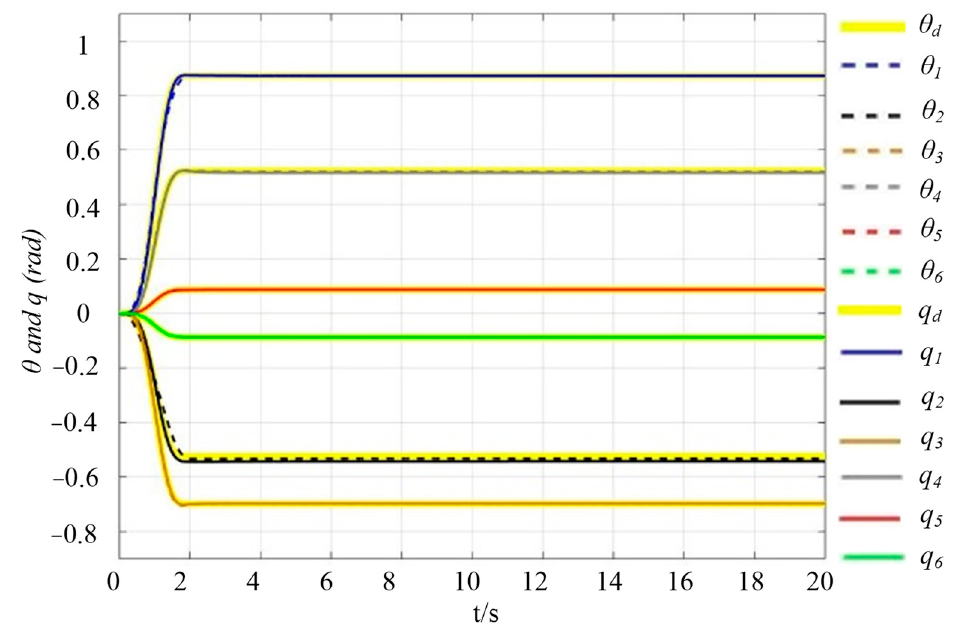
Figure 6. Motor- and link-side angular displacements using the VH-ILC-ET method. (solid line: link side, dotted line: motor side).